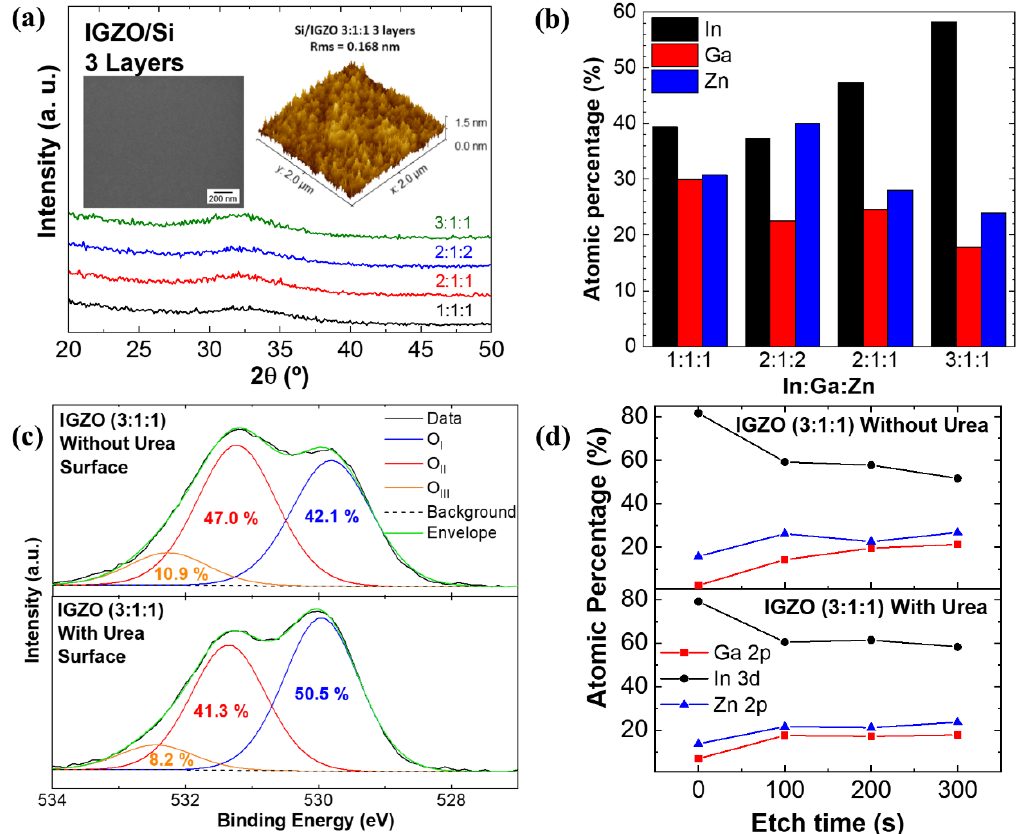
Figure 2. ( a ) X-Ray diffraction (XRD) of combustion IGZO films with different In:Ga:Zn ratio; inset shows the scanning electron microscopy (SEM) surface image and atomic force microscopy (AFM) topography of 3-layer IGZO 3:1:1; ( b ) atomic concentration (%) of each metallic cation in